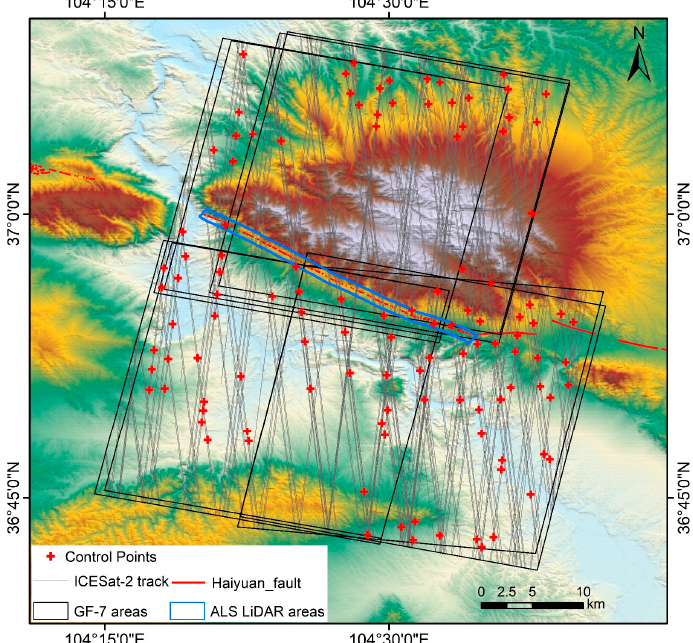
Figure 4. The location and distribution of the GCPs extracted from the ICESat-2/ATLAS data.